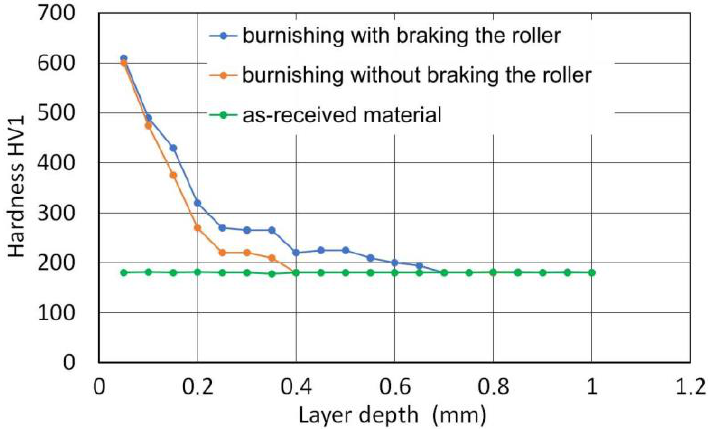
Figure 14. Effect of the surface layer depth on the cross-section hardness HV1 of ring (roller pressure force F = 5 kN).